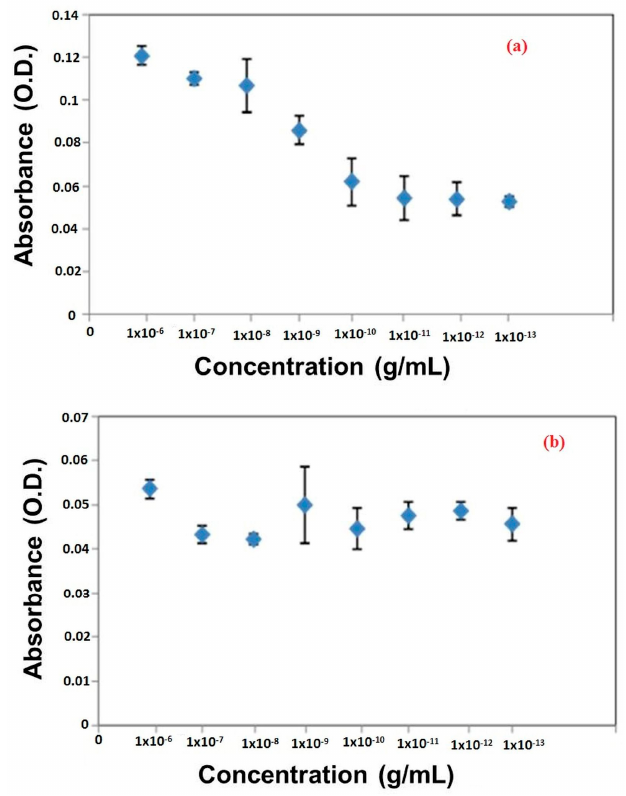
Figure 2. Optimization of ( a ) primary and ( b ) secondary antibodies.